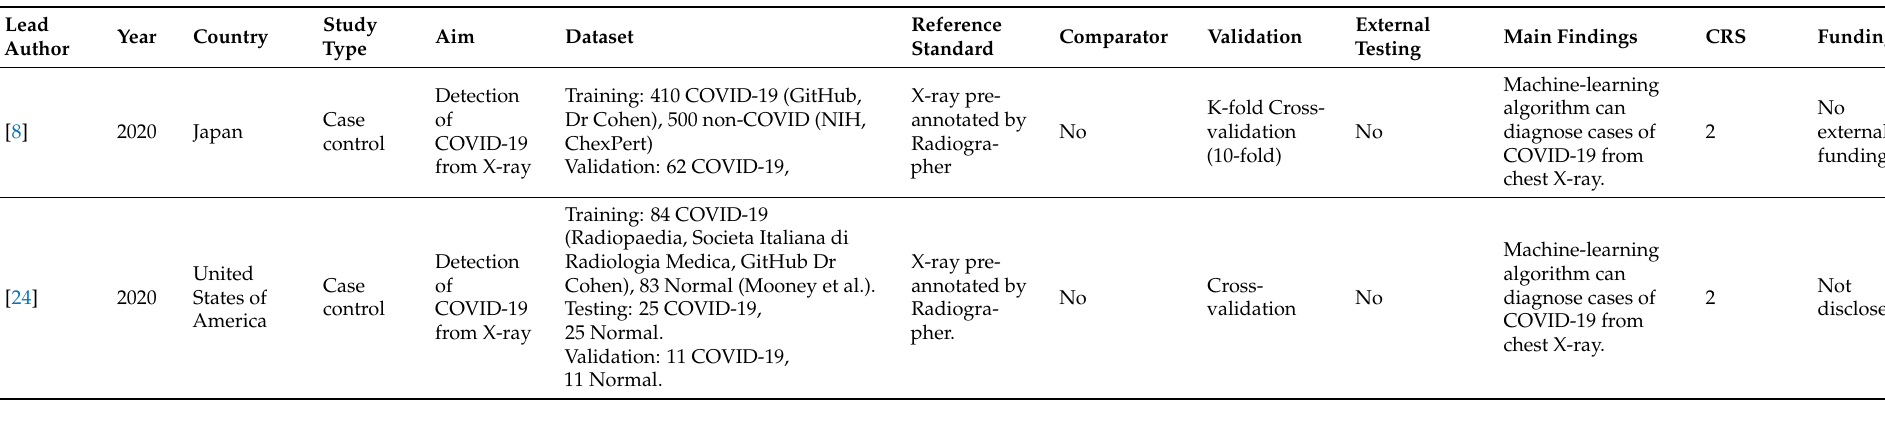
Table 2. Modified TRIPOD assessment for CT